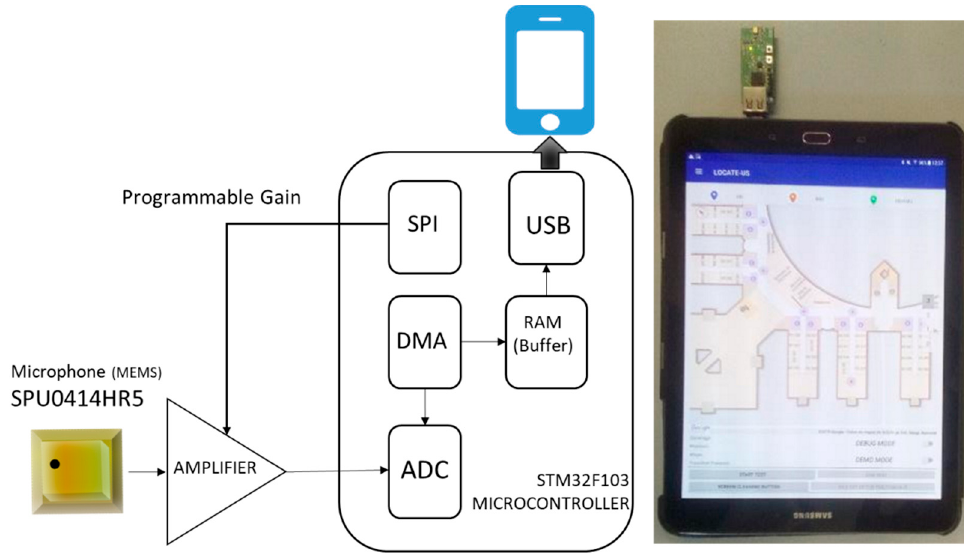
Figure 3. Block diagram and view of the acquisition module for LOCATE-US.